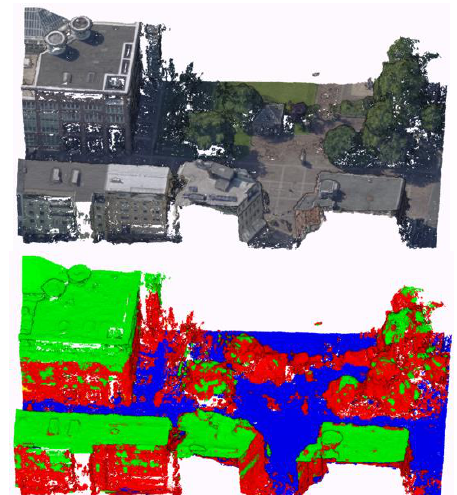
Figure 16. A portion of the Dortmund benchmark dataset, original cloud part (top), and classified (bottom) with 4-class classifier: roofs (green), vegetation (red) and GLOs